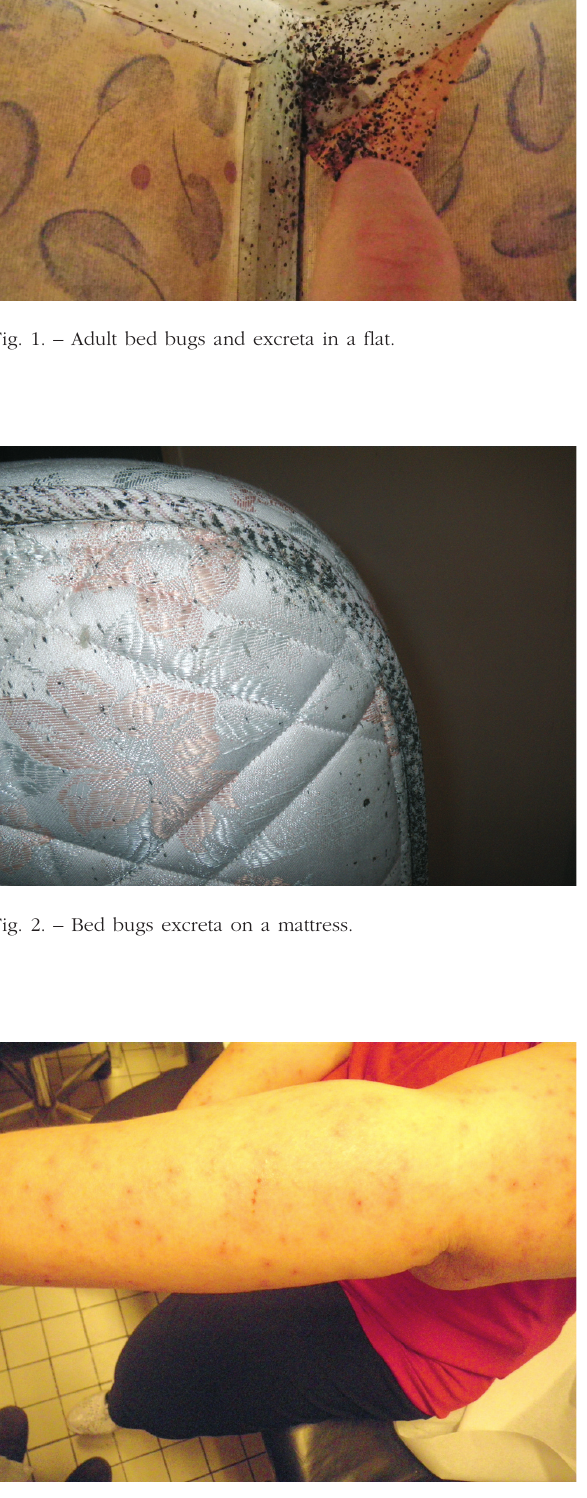
Fig. 3. – Lesions on a human arm caused by bed bugs